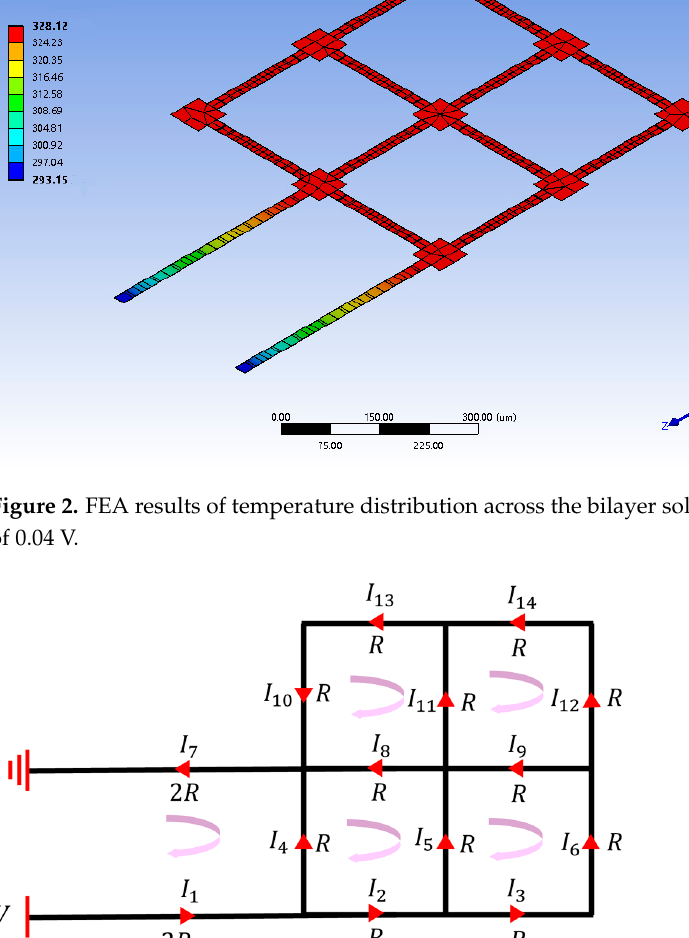
Figure 2. FEA results of temperature distribution across the bilayer solar sail by applying a voltage of 0.04 V.